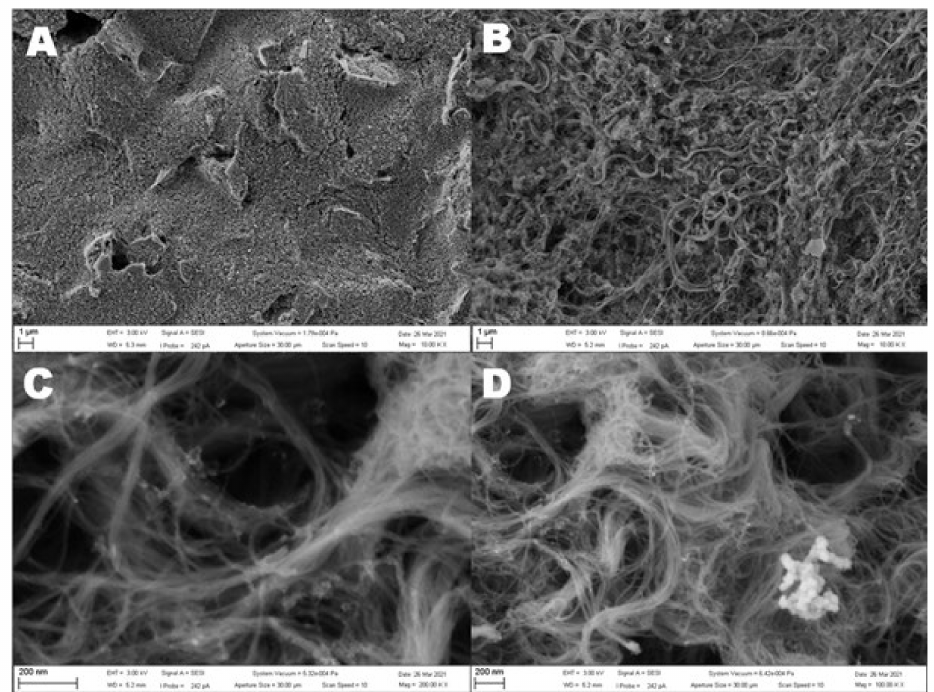
Figure 2. SEM images of the screen-printed electrode ( A ) and SPCE/MWCNT/NiO1.5 ( B – D ). ( A , B ) A scale of 1 µ m and a magnitude of 50.00 kx. ( C ) A scale of 200 nm and a magnitude of 200 kx and 100 kx ( D ).